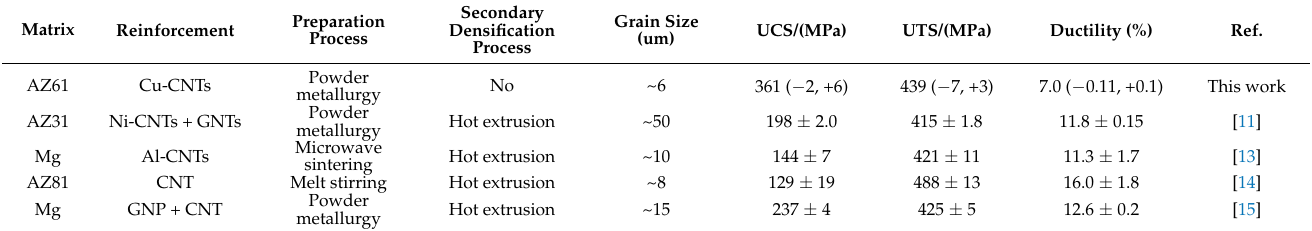
Table 1. Comparison of compressive properties of magnesium matrix composites in the literature.